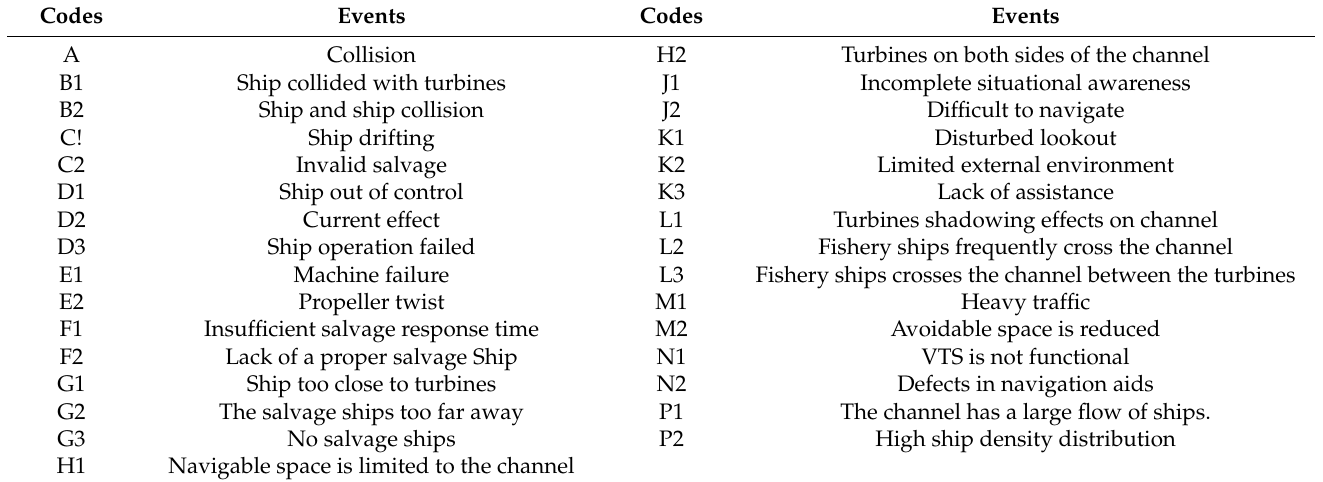
Table 1. Events and codes of FTA for risks in the navigation channel within the offshore wind farm. Codes